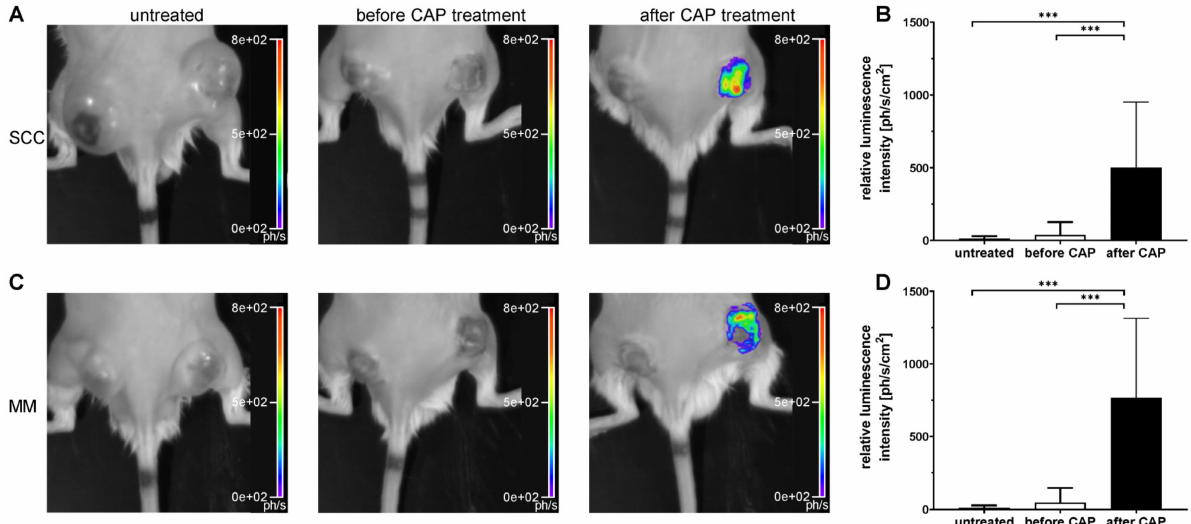
Figure 4. Representative luminescence images ( A , C ; luminescence probe: L-012) and quantitative assessment of relative luminescence intensity ( B , D ). NSG mice with two s.c. flank tumours, either squamous cell carcinoma (SCC) or malignant melanoma (MM), were treated with or without cold atmospheric pressure plasma (CAP) over three weeks. CAP treatment started four days after tumour cell injection and was repeated every four days. L-012 was injected i.p. and the luminescence intensity was measured before and after CAP treatment. The measurement was performed two hours before and immedi- ately after the CAP treatment. Data are presented as mean ± SD ( n = 10–15); one-way ANOVA followed by Tukey’s multiple comparison. *** p ≤ 0.001 vs. untreated SCC or MM, respectively or before CAP treatment of SCC or MM,